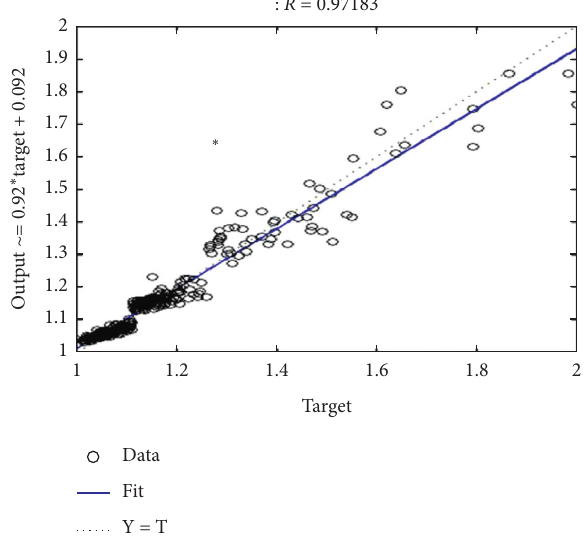
Figure 7: Performance regression plot of the INTS